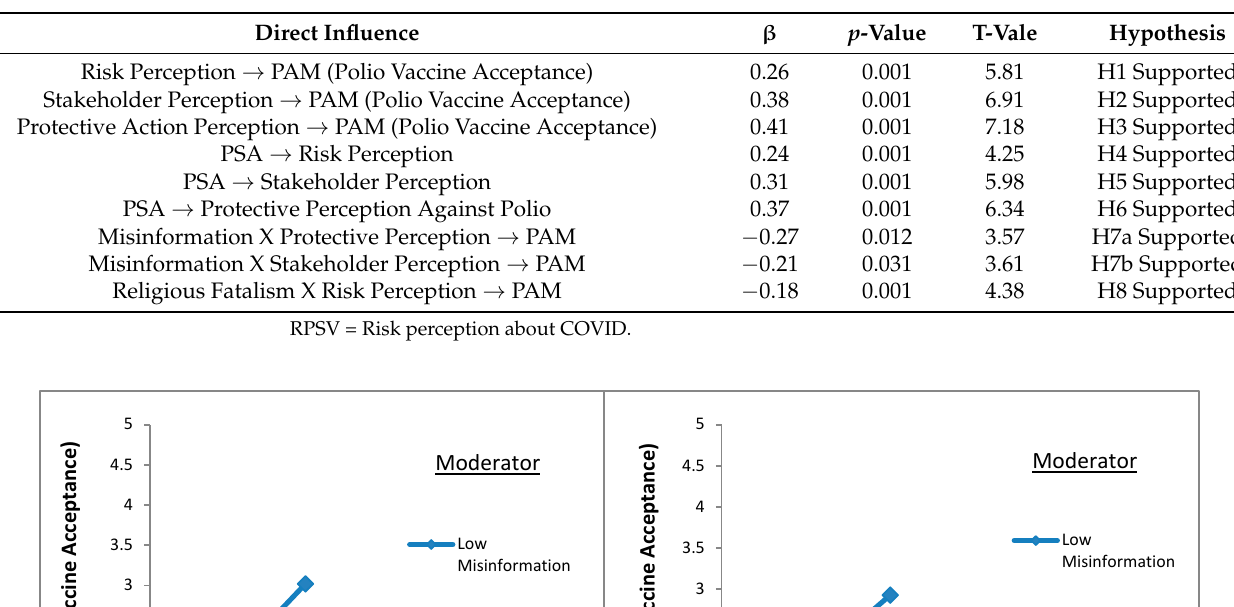
Table 4. Hypothesis testing.